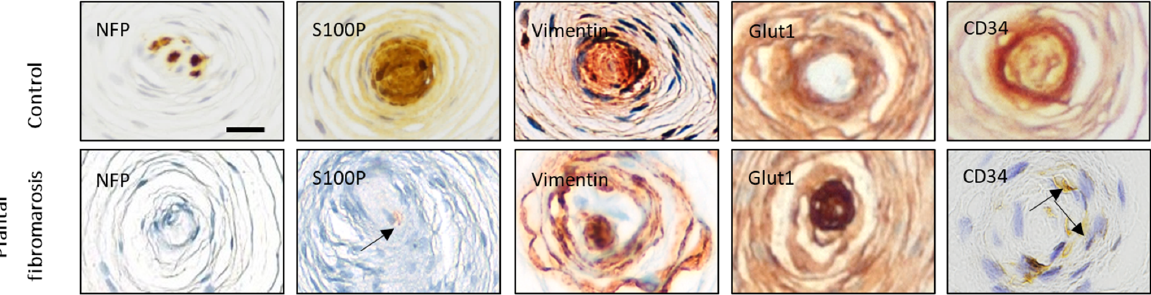
Figure 4. Representative images of the changes in the expression of some selected antigens in the Pacinian corpuscles of Ledderhose disease compared with controls. Scale bar = 25 μ m.